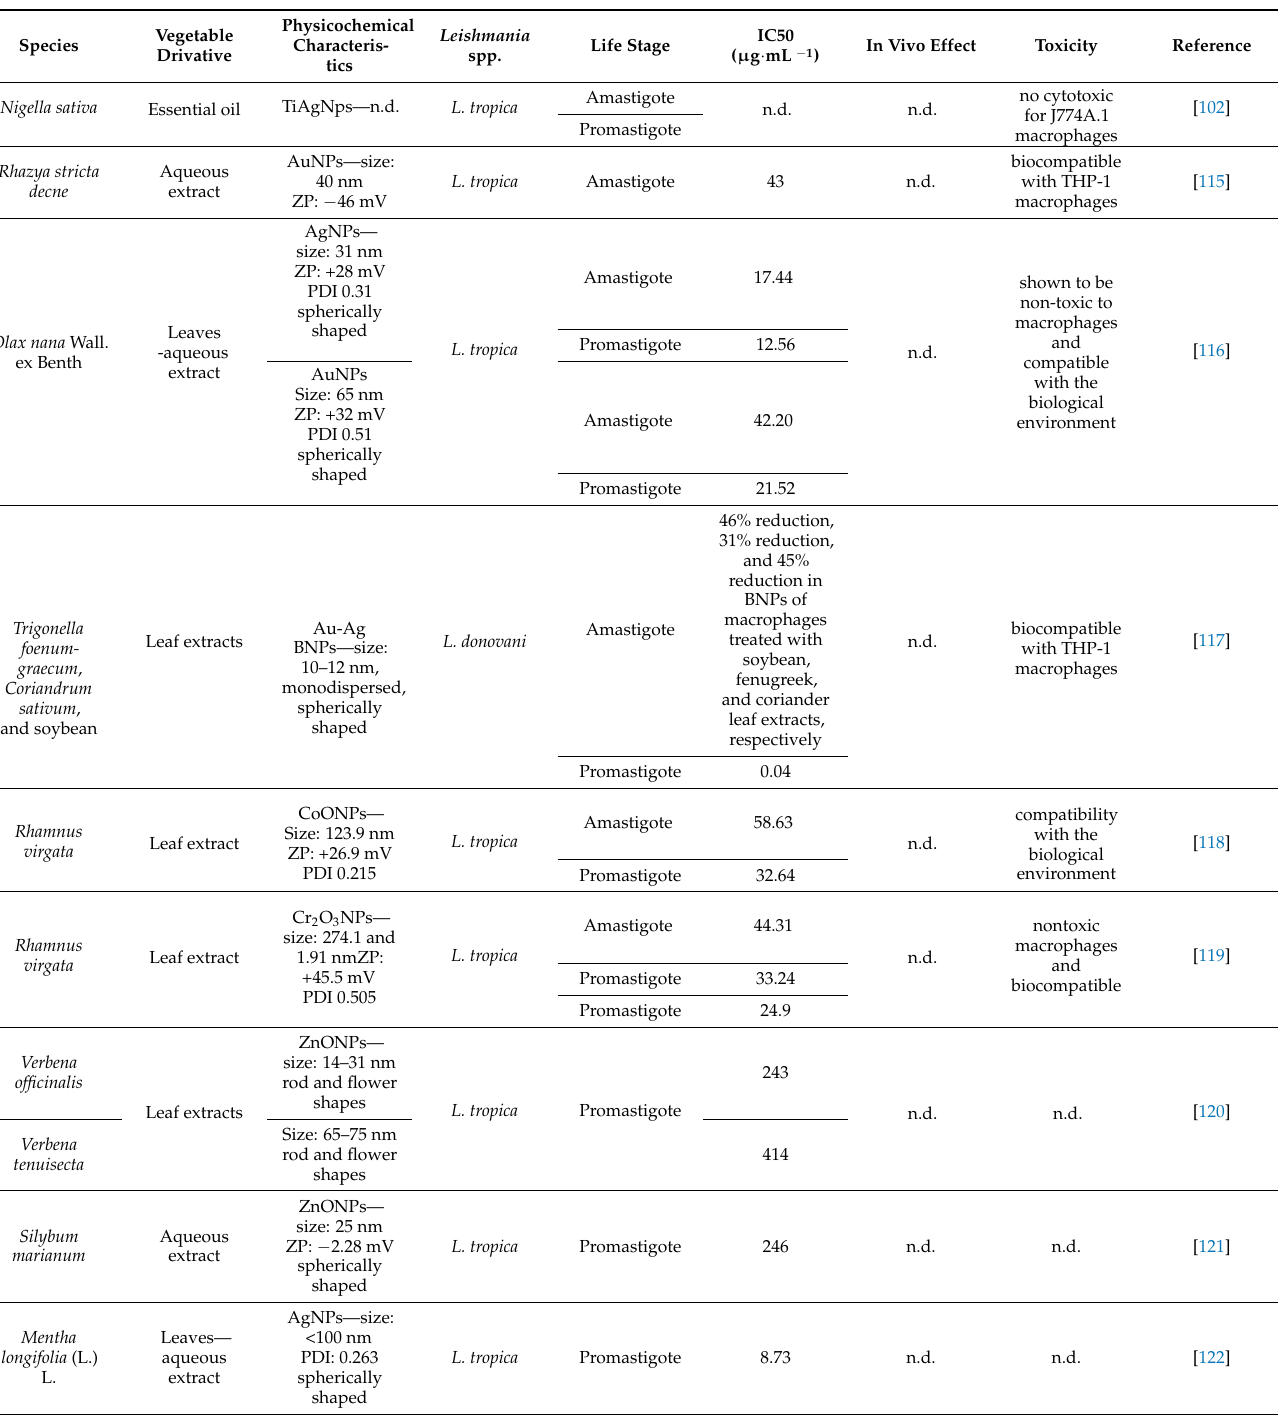
Table 5. Plant-based metallic nanoparticles as antileishimanicidal